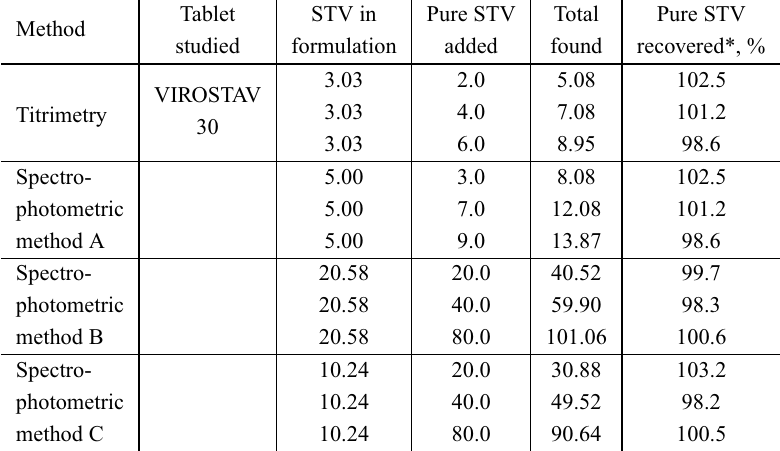
Results of recovery study via standard-addition